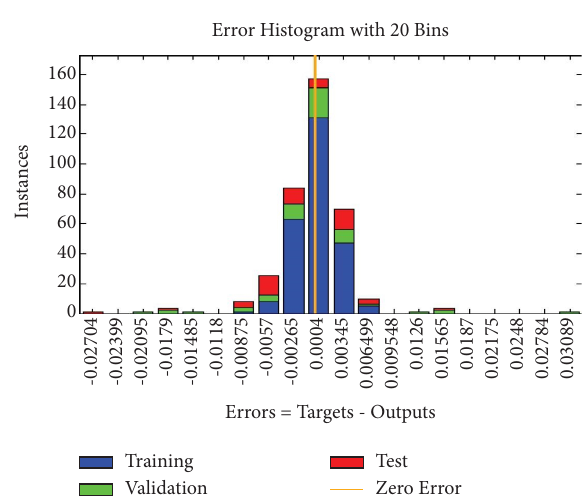
Figure 7: Error histogram for proposed wavelet-ANN.